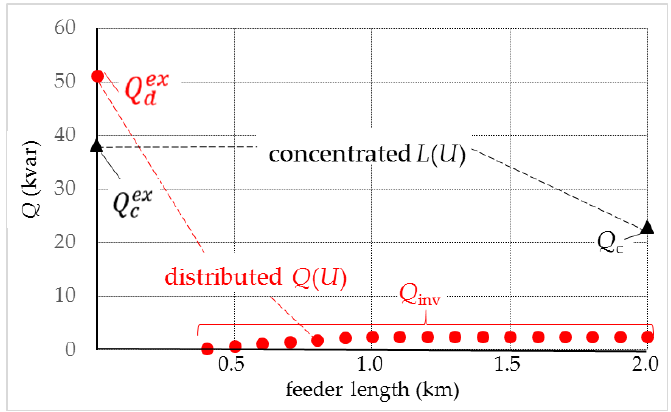
Figure 16. The consumed reactive power and the Q ex flows for the Q ( U ) and L ( U ) control